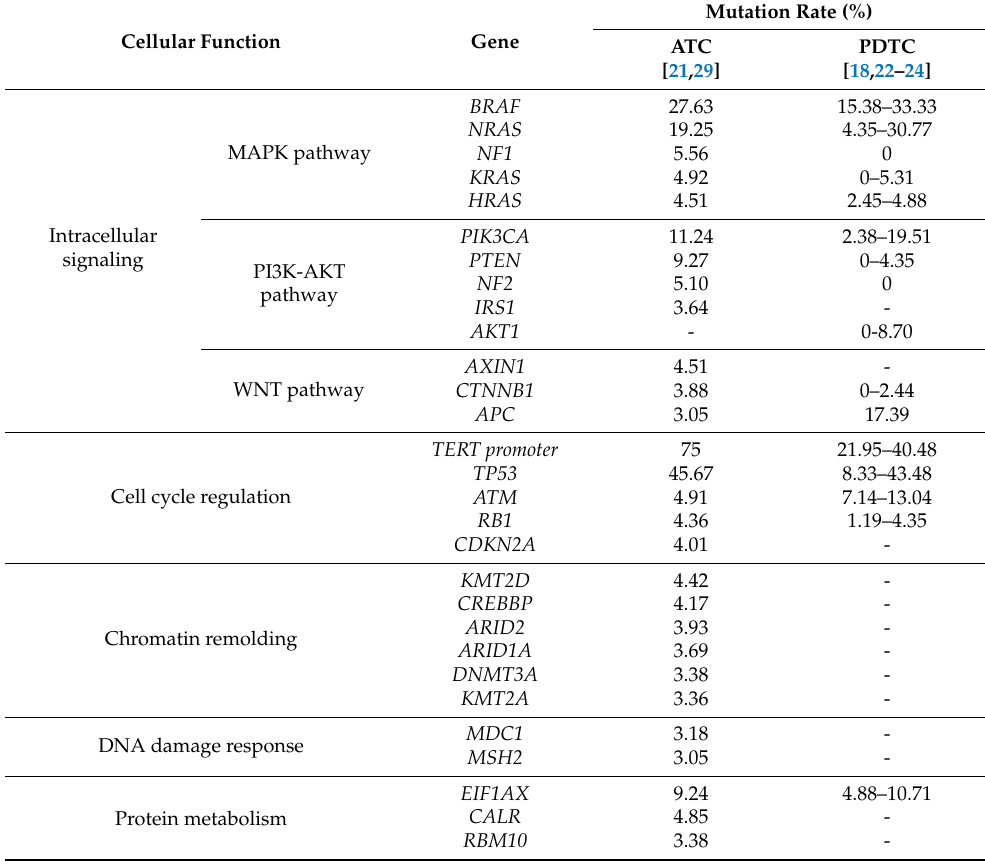
Table 1. ATC and PDTC genetic landscape: somatic